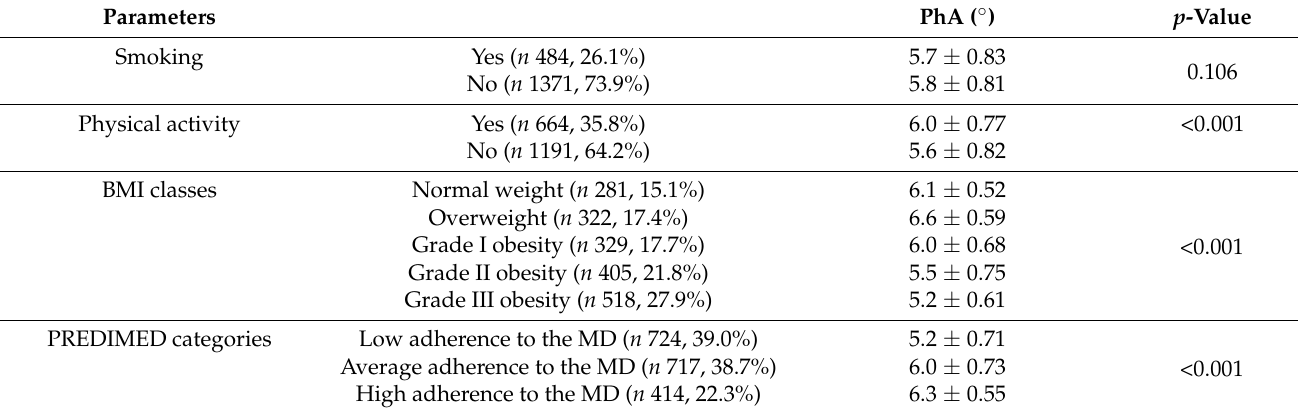
Table 2. PhA in the study population according to smoking, physical activity, and BMI classes, and PREDIMED categories. Parameters